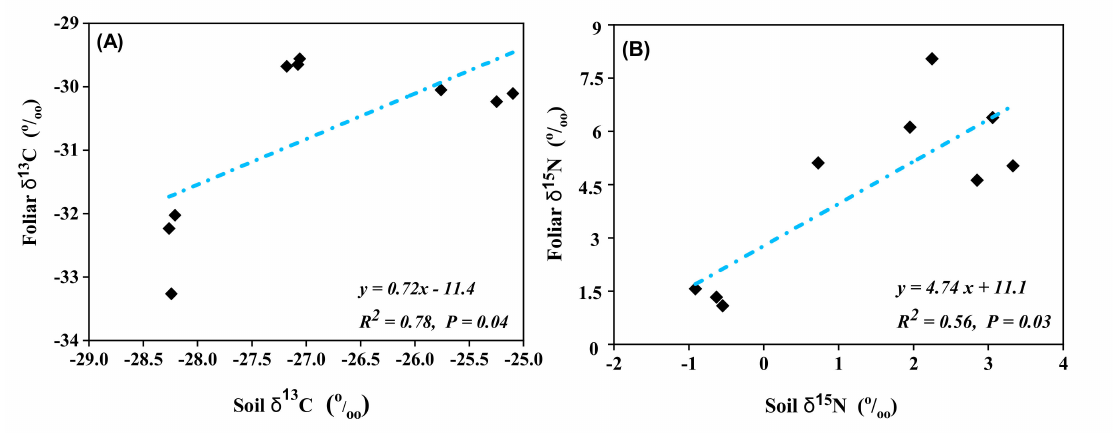
Figure 3. Linear relationships between ( A ) soil and foliar δ 13 C and ( B ) soil and foliar δ 15 N (‰) across three forest types at a 0–40 cm soil